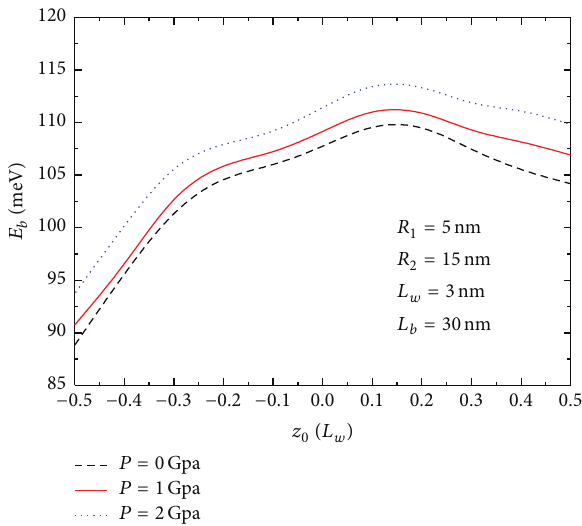
Figure 7: The ground-state donor binding energy in cylindrical wurtzite GaN/Al 𝑥 Ga 1−𝑥 N strained QR as a function of the axial impurity position 𝑧 0 for 𝑅 1 = 5 nm, 𝑅 2 = 15 nm, 𝐿 𝑤 = 3 nm, = 30 nm, and several values of the hydrostatic pressure (𝑃) 𝐿 𝑏